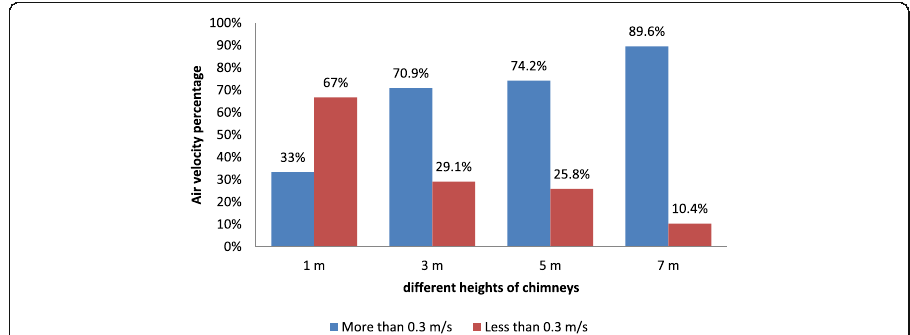
Fig. 23 Percentage of both critical and comfort area to the total area of the tested zone concerning indoor air velocity for different heights of the chimney at the breathing level zone 1.2 m (source: the